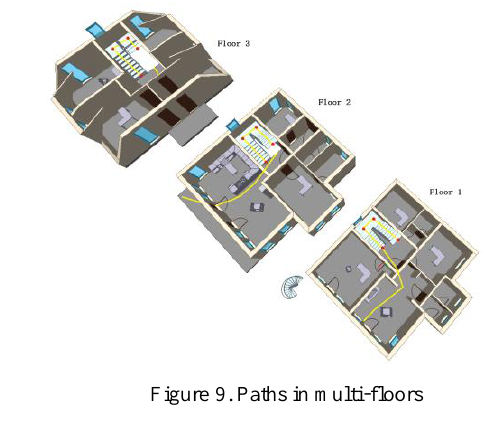
Figure 9. Paths in multi-floors